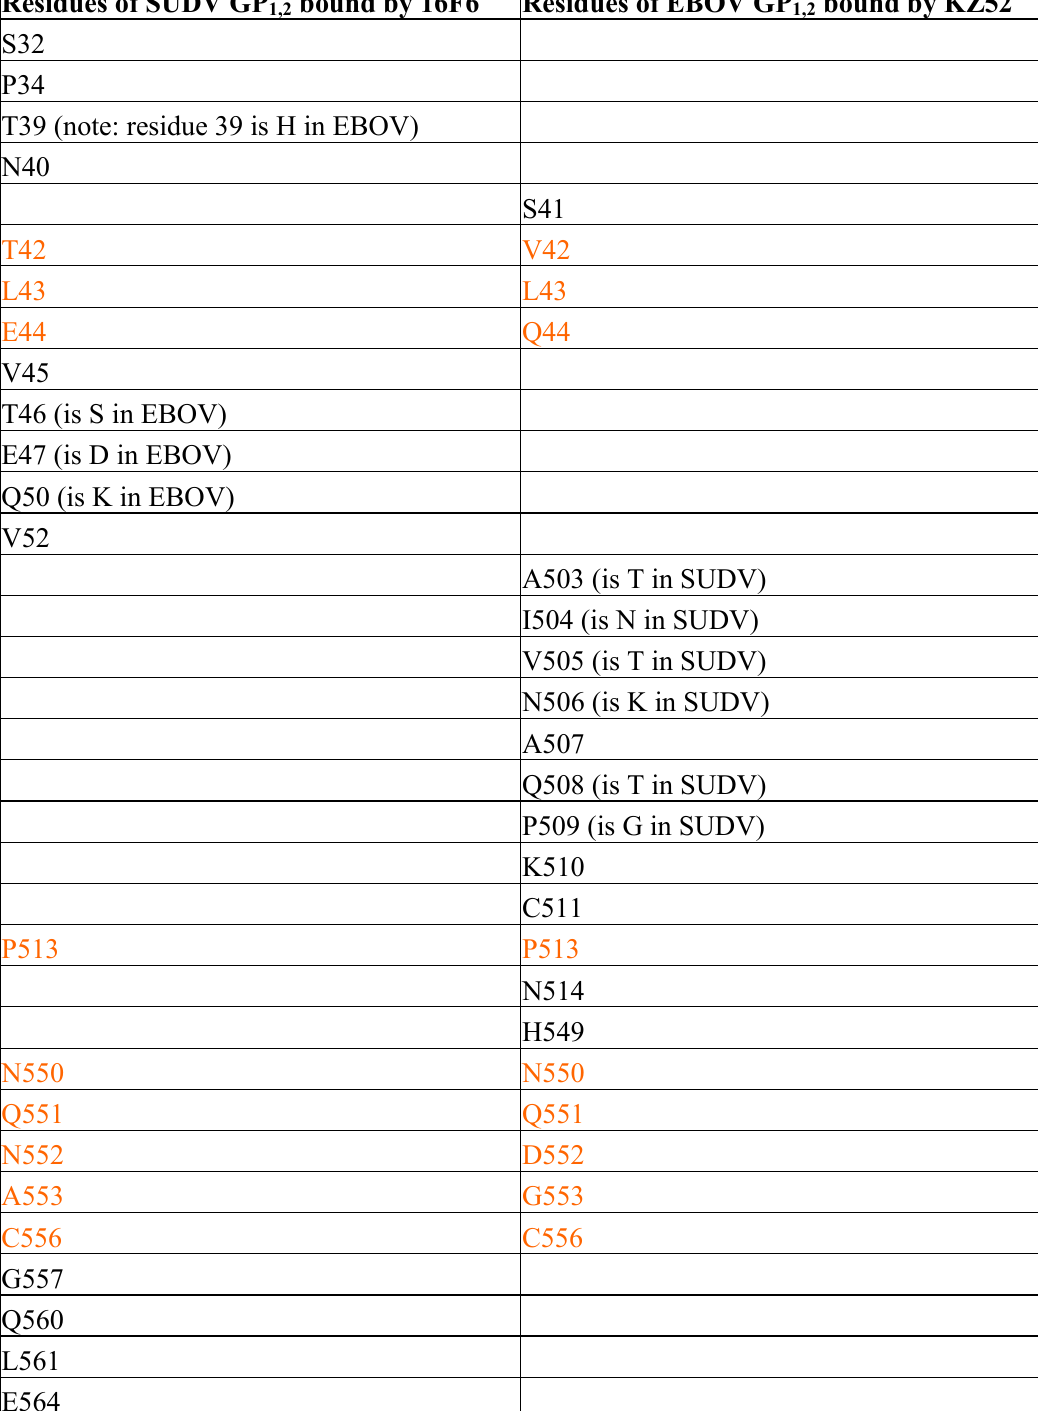
Table 3. Comparison of the 16F6 and KZ52 epitopes on SUDV and EBOV GP respectively. Residues at the shared intersection of the two epitopes are colored orange. Residues listed are conserved between SUDV and EBOV, unless